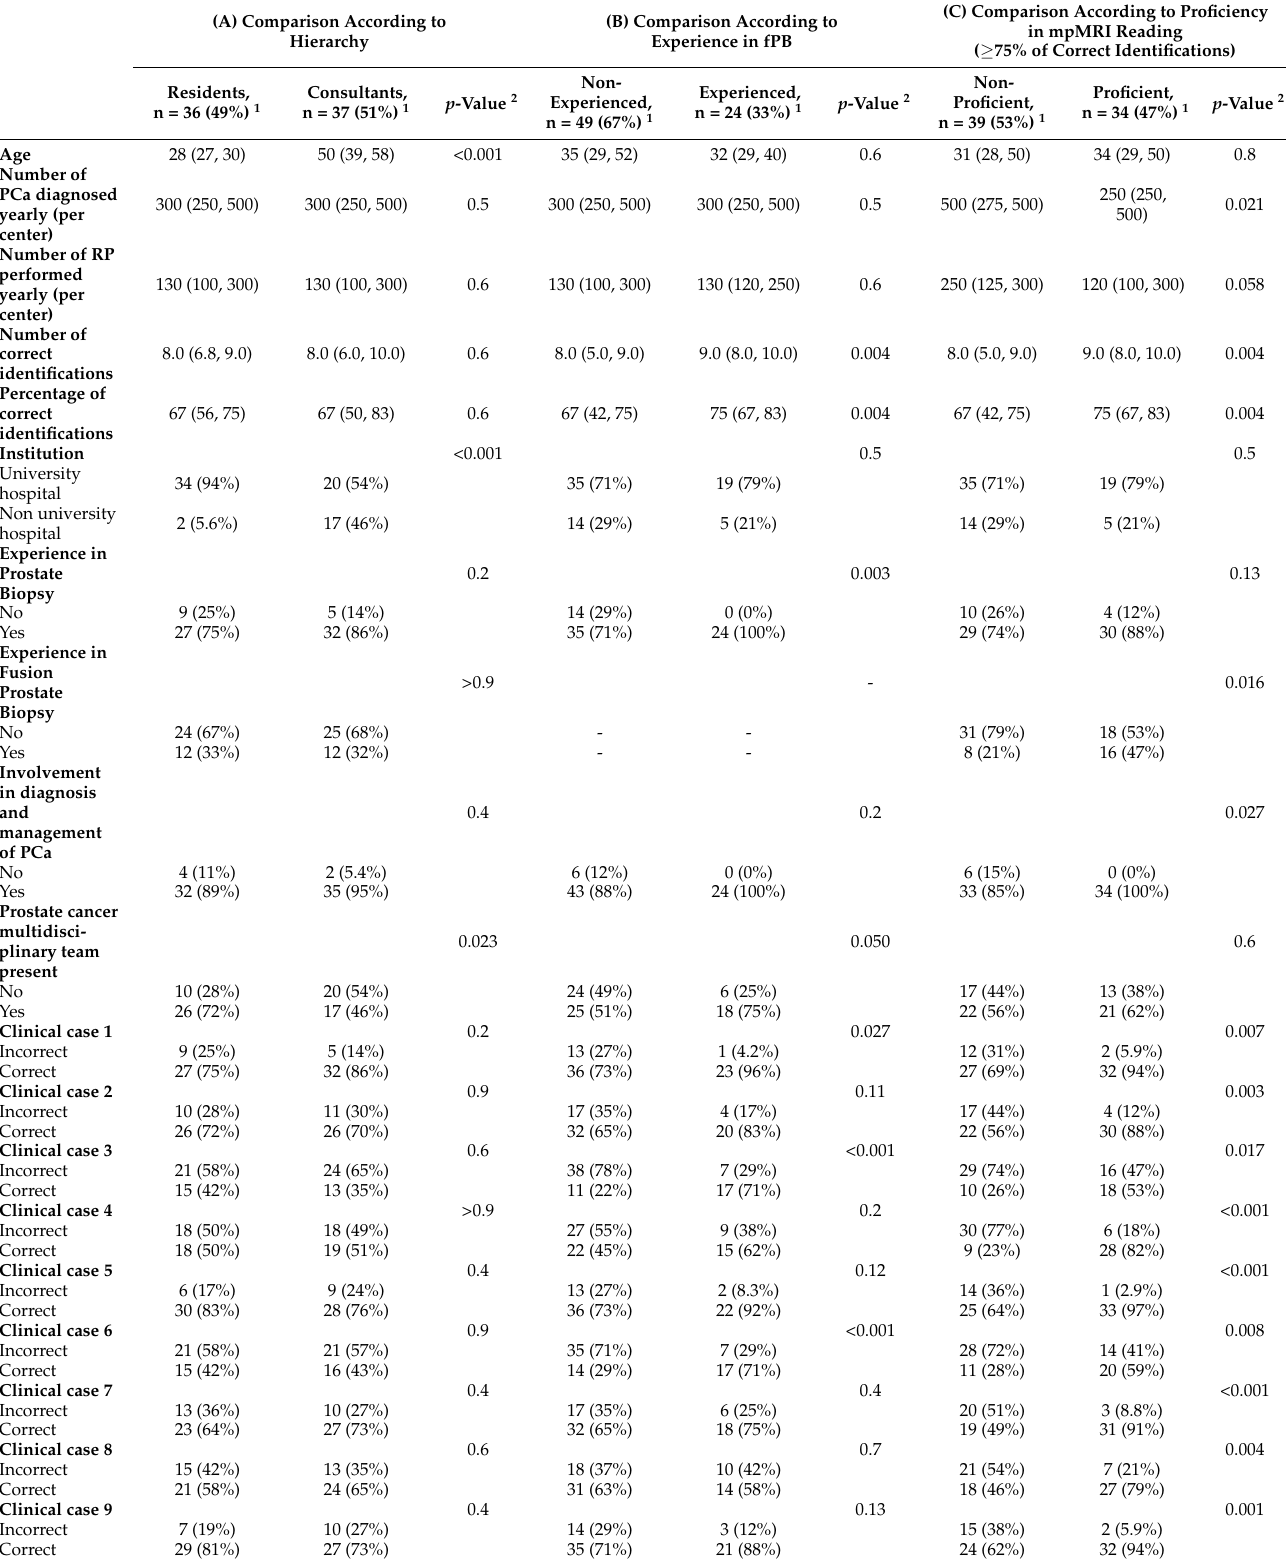
Table 1. ( A – C ) Characteristics of 72 responders, stratified according to: ( A ) hierarchy (residents vs. consultants); ( B ) experience in fusion prostate biopsy (non-experienced vs. experienced); ( C )